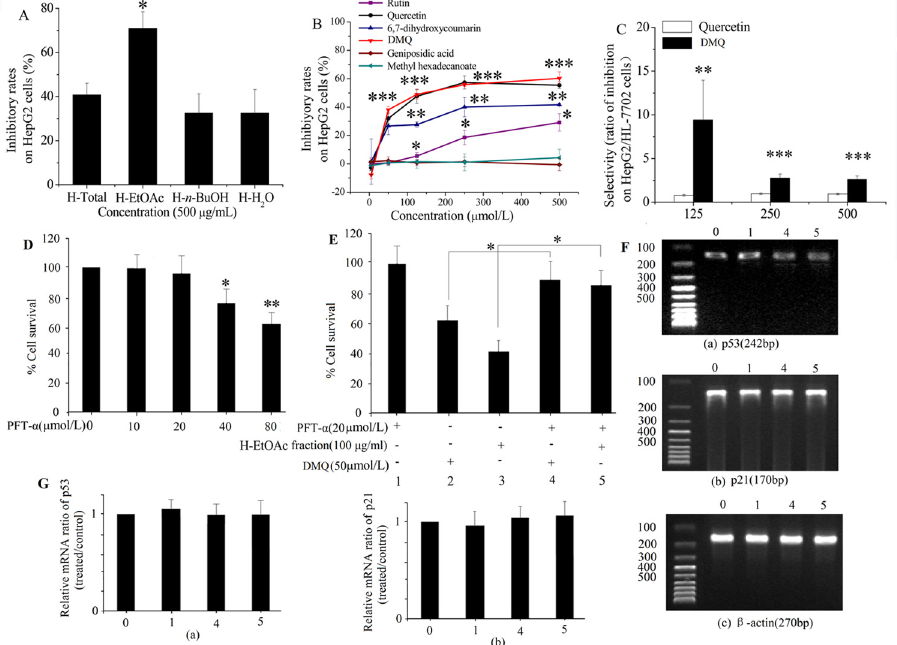
Fig 1. The Anticancer Effects of H-EtOAc Fraction and DMQ. A. The inhibitory effects of four fractions on HepG2 cells at 500 μ g/mL for 24 h. B. The inhibitory effects of six indentified components on HepG2 cells at gradient concentrations (0, 5, 50, 125, 250 and 500 μ mol/L) for 24 h (the inhibitory effect of geniposidic acid group was the control). C. The selectivity rates of two high anticancer components between HepG2 and HL- 7702 cells (the selectivity of quercetin was the control). D. HepG2 cells were treated with varying concentrations of PFT- α (0 – 80 μ mol/L) for 24 h and cell survival was evaluated by SRB assay (0 μ mol/L PFT- α group was the control). E. Viability of HepG2 cells were treated with/without indicated concentration of DMQ and H-EtOAc fraction plus PFT-alpha for 24 h by SRB assay (the group of 20 μ mol/L PFT- α without DMQ and H-EtOAc fraction treatment was the control). F. RT-PCR results of p53, p21and β -actin in HepG2 cells. G. mRNA levels of p53 and p21 in HepG2 cells. Line 0: the control (without PFT- α , DMQ and H-EtOAc fraction). Line 1: PFT- α (20 μ mol/L) without DMQ and H-EtOAc fraction. Line 2: DMQ (50 μ mol/L) and PFT- α (0 μ mol/L). Line 3: H-EtOAc fraction (100 μ g/ml) and PFT- α (0 μ mol/L) Line 4: DMQ (50 μ mol/L) and PFT- α (20 μ mol/L). Line 5: H-EtOAc fraction (100 μ g/ml) and PFT- α (20 μ mol/L). The strength ofmRNA expression signal were analyzed by scanning densitometry using a Microtek ScanMaker 8700 (Zhongjing Inc. China) with ScanWizard 5 software. Values are means ± SD of three independent experiments. * ( p < 0.05), ** ( p < 0.01) and *** ( p < 0.001) represented significant differences compared to the